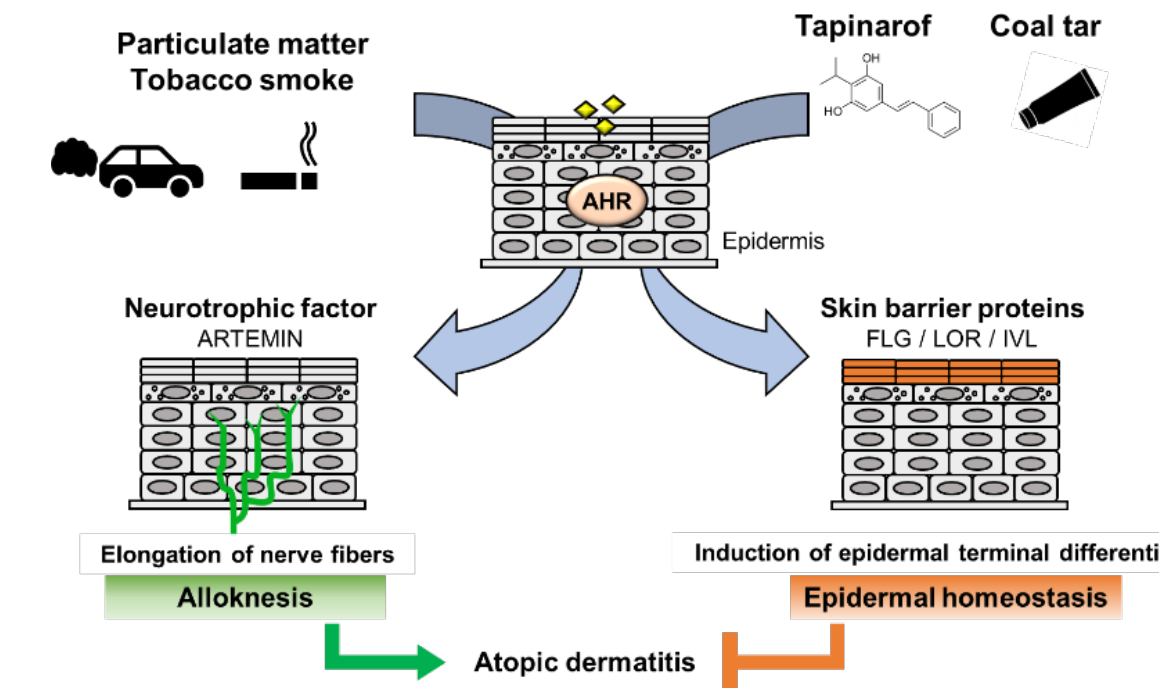
Figure 4. Dual functions of AHR in atopic dermatitis. PM and tobacco smoke contain PAHs that activate AHR. Activation of AHR induces the expression of the neurotrophic factor Artemin. Upregulation of Artemin causes extension of cutaneous sensory nerves into the epidermis and provokes hypersensitivity to itch or alloknesis. Tapinarof and coal tar improve skin barrier function by accelerating epidermal terminal differentiation.